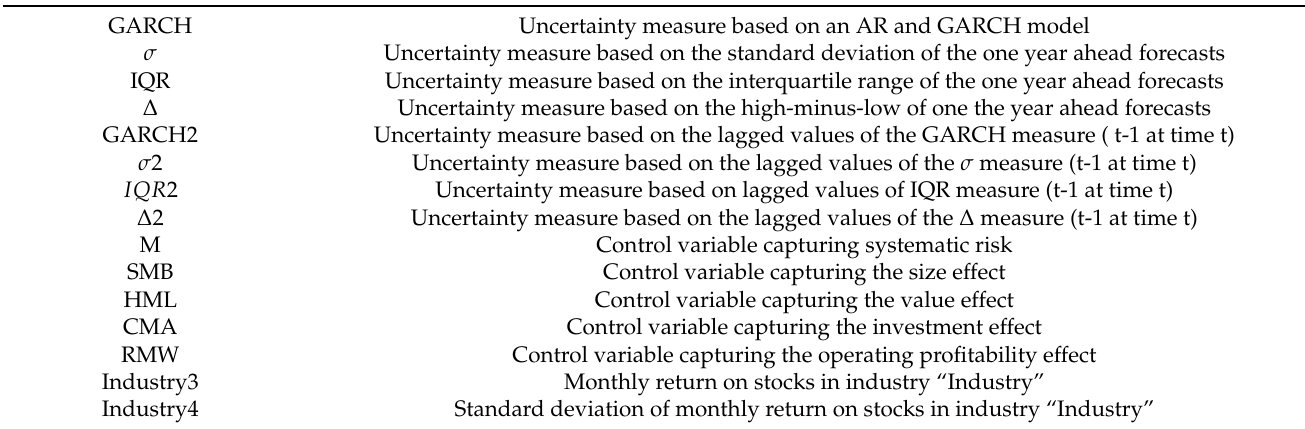
Table 1. Summary of all